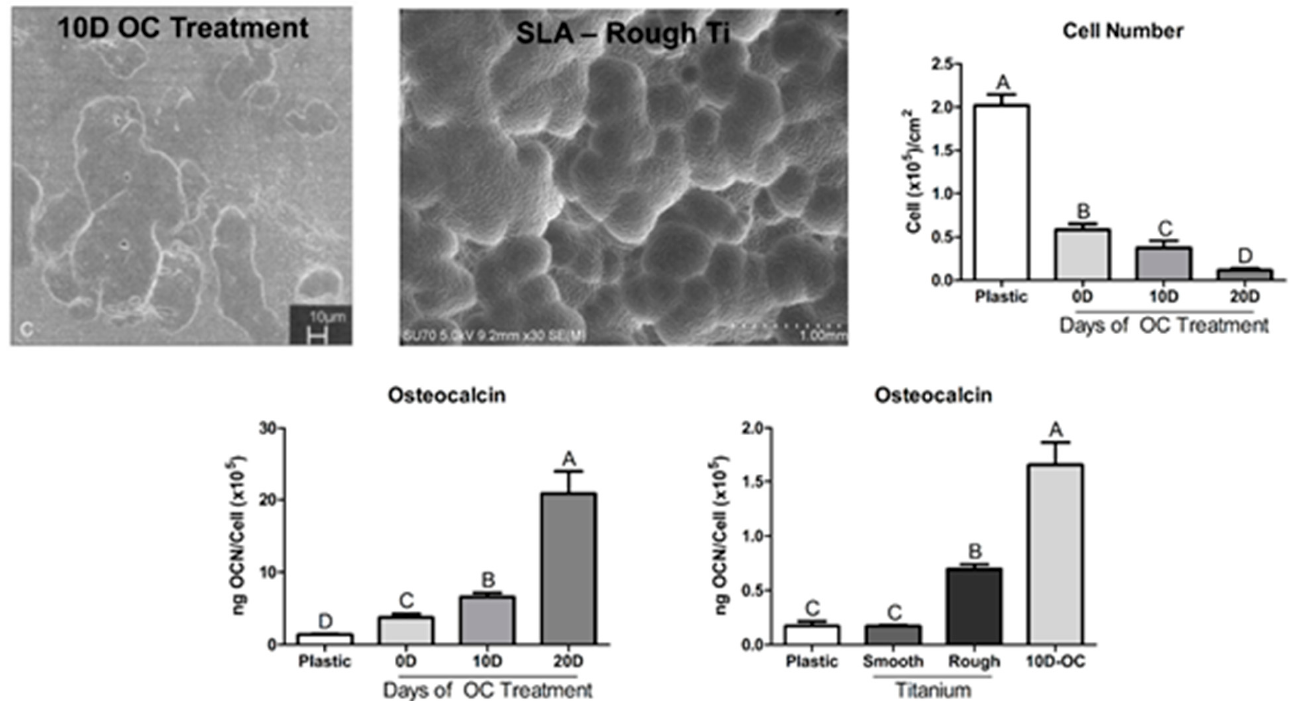
Figure 2. Osteoclast treatment of bone wafers conditions the surface of the bone to stimulate osteoblastic differentiation of osteoprogenitor cells [34]. Scanning electron imaging of an osteoclast modified bone surface at 10 days shows topographical alterations as the mineral is resorbed away. Culturing cells on bone wafers increases osteoblastic differentiation without modification by osteoclasts and increasing the length of surface modification by bone resorbing osteoclasts increased the differentiation of osteoprogenitor cells and osteocalcin production. Groups not sharing letters are significant at a p -value of <0.05.